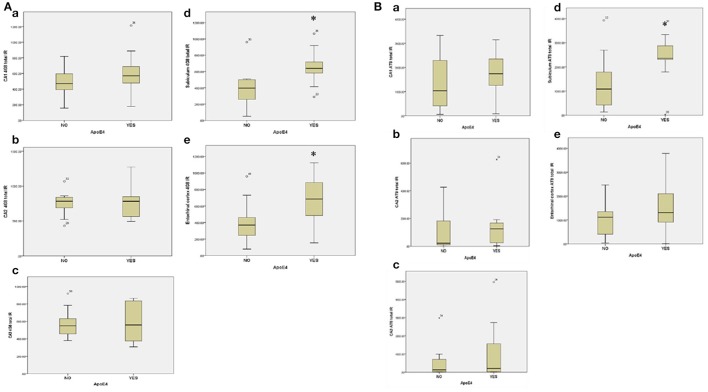
(A) Box Plots showing the influence of Apo E ε4 on total amyloid deposition across hippocampal sub-regions (a) CA1, (b) CA2, (c) CA3, (d) Subicuhun, and [e] Emorlrinal conex in the post-stroke sub-cohort Mann–Whitney U-test was used to compare the mean 4G8 total immunoreactivity between the Apo E ε4 positive and negative groups respectively. *p < 0.05. (B) Box Plot showing the influence of Apo E ε4 on total tau (AT8) deposition across hippocampal sub-regions (a) CA1 (b) CA2 (c) CA3 (d) Subiculum and (e) Entorhinol cortex in the post-stroke sub-cohort. Mann Whitney U-test was used to compare mean AT8 total immunoreactivity between the Apo E ε4 positive and negative groups respectively. *p < 0.05.